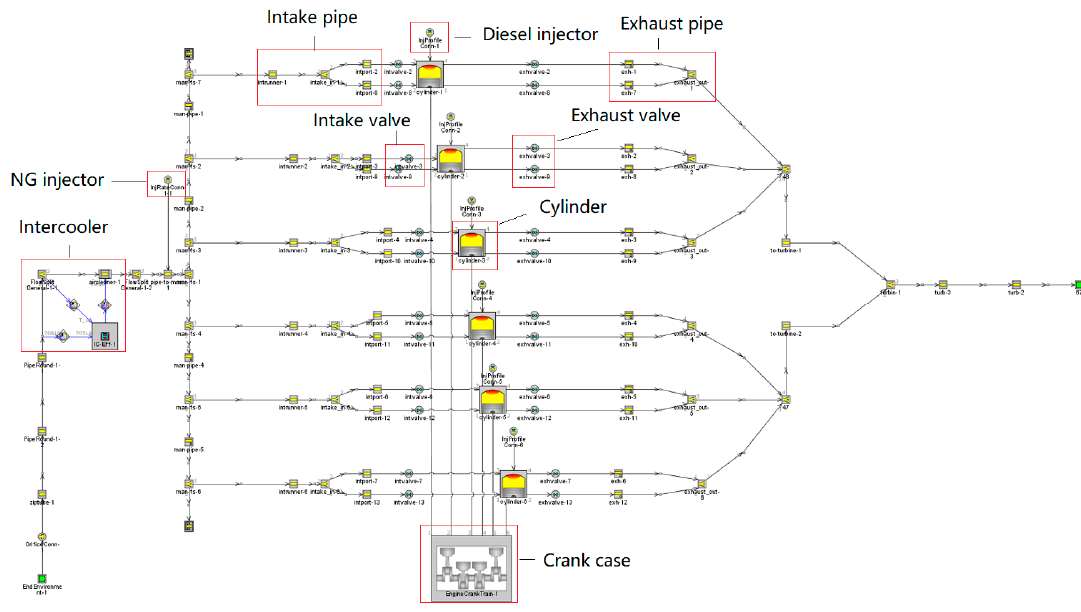
Figure 2. GT Power model for the Engine B.